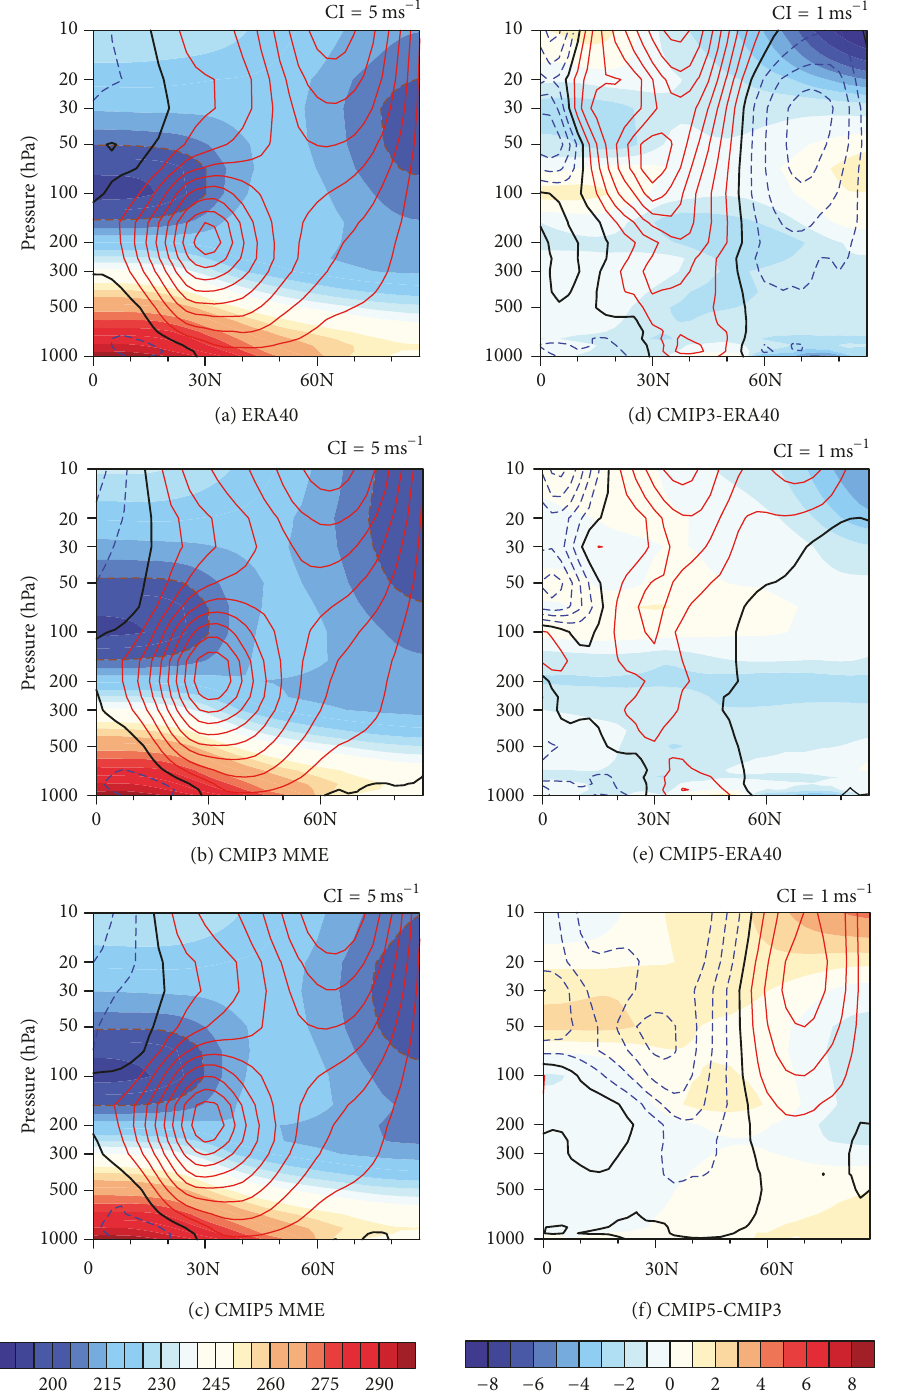
Figure 2: The 30-year climatology (left panel) and discrepancies between each ensemble’s (right panel) boreal winter (DJF) zonal-mean temperatures (shadings, unit: K) and zonal-mean zonal winds (contours, unit: ms −1 ). The contour intervals of the left and right panels are 5ms −1 and 1ms −1 ,